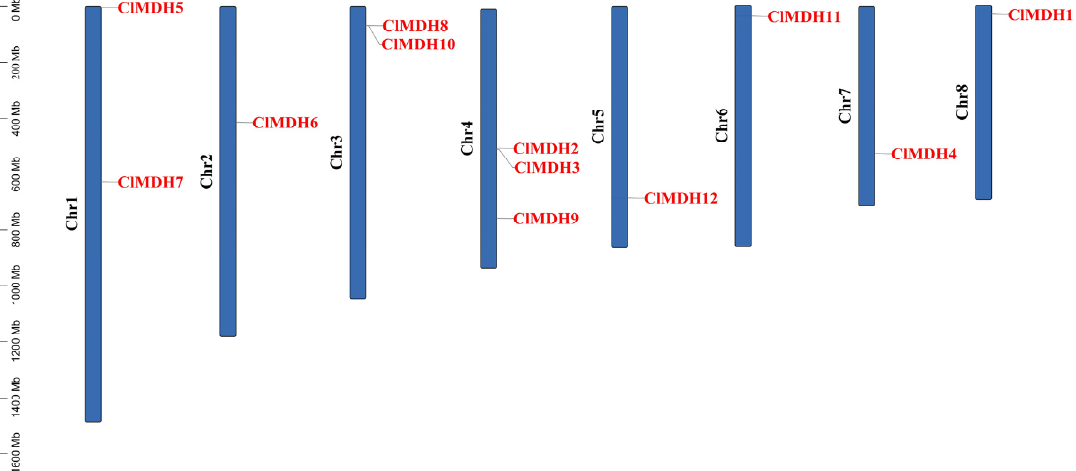
Figure 5. Genomic location of ClMDH genes on Chinese fir chromosomes. Chromosomal location of ClMDH genes, the scale represents the 1600 Mb chromosomal distance, and the ClMDH genes are represented in red color.